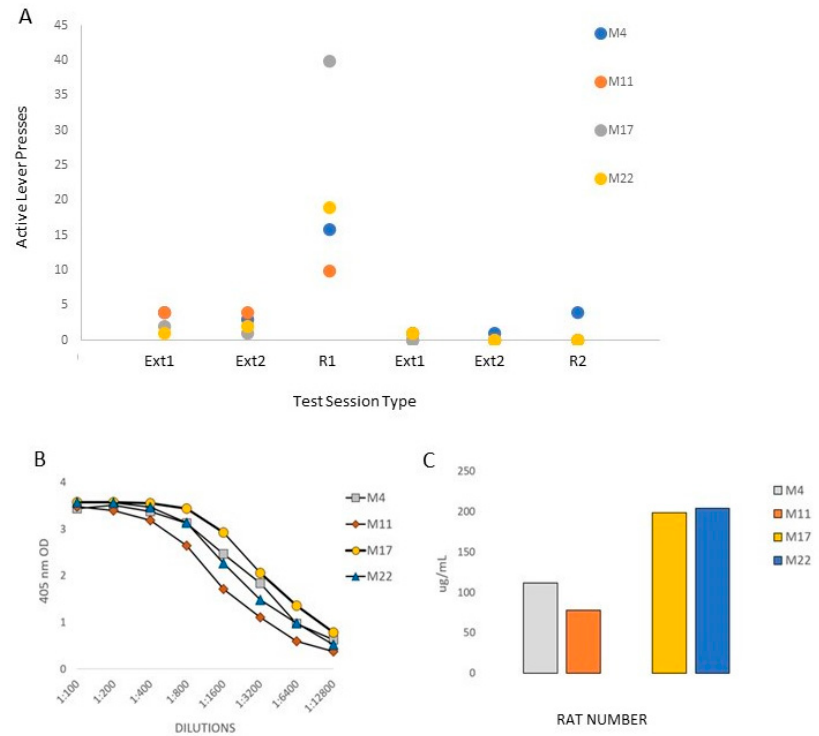
Figure 4. Passive immunization with anti-MA antibodies blocks drug-induced reinstatement of MA-seeking behavior. Data presented are from two female (M4 and M11) and two male (M17 and M22) rats that were tested at baseline then after being passively immunized with antibodies generated from the TT-SMA vaccine with entolimod. ( A ) After rats underwent extinction (EX1-EX2), rats received an IP injection of MA (2 mg/kg; R1) that produced a significant increase in lever pressing (i.e., drug-seeking). Following reinstatement tests, extinction training resumed and rats were passively immunized with anti-MA antibodies. After passive immunization, rats received another dose of MA (R2). Passive immunization with anti-MA antibodies significantly blocked drug-seeking behavior and three of four rats that showed no lever pressing. ( B ) Serial dilutions of serum from each rat and ( C ) the total anti-MA antibody levels are presented.